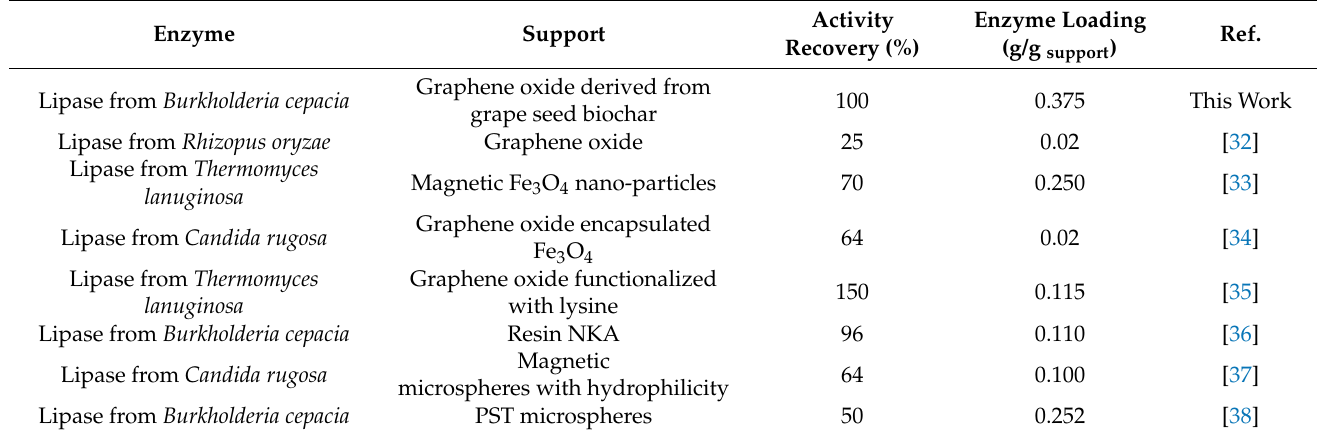
Table 1. Enzyme loading values (g/g of support) and activity recovery (%) of different enzymes and